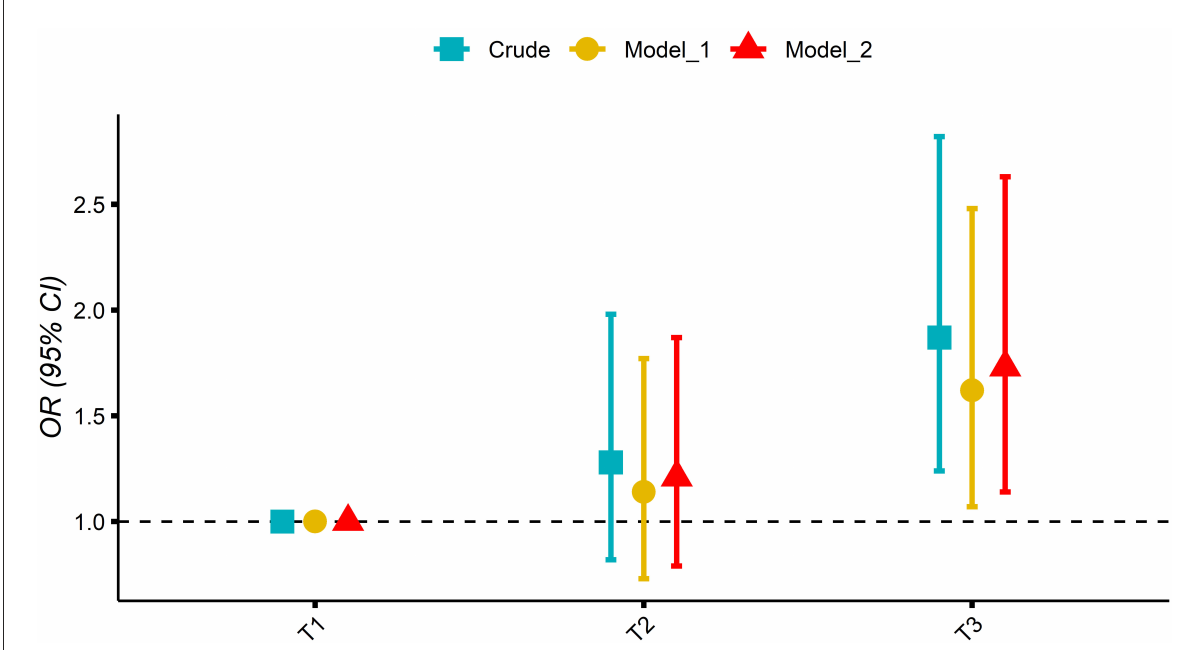
FIGURE2 Association of tertile of the modified dietary inflammatory index (MDII) score with osteoporosis (OP) in participants; mode 1 adjusted: age and sex; model 2 adjusted: model 1 plus hypertension, smoking status, physical activity, history of fracture, DM, race, BMI, education, history of prednisone or cortisone, calcium intake, alcohol use, and poverty index.